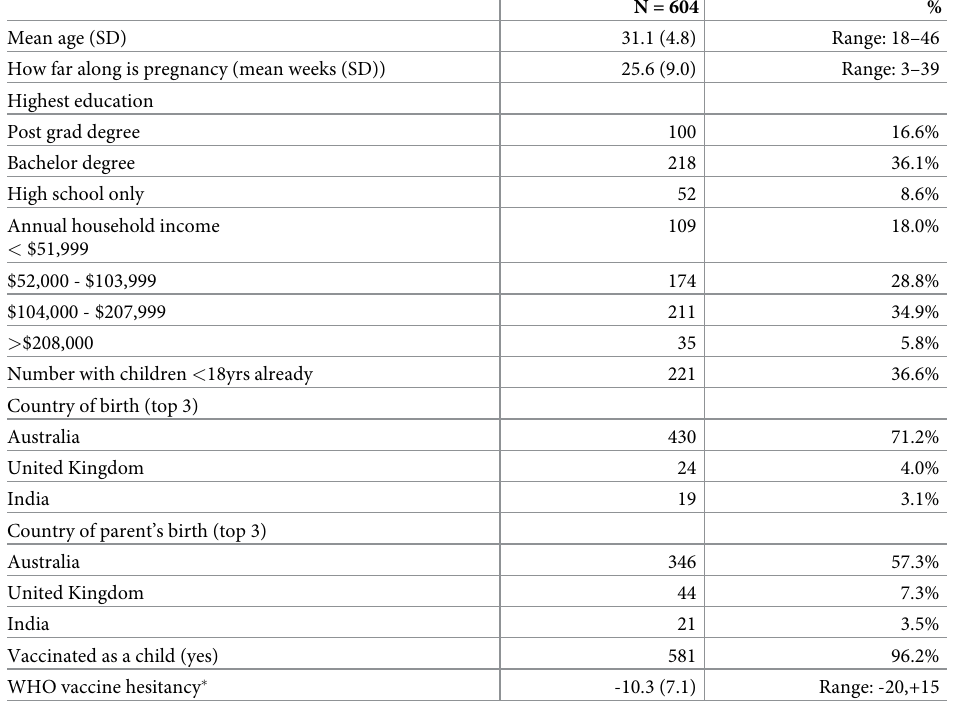
Table 2. Respondents’